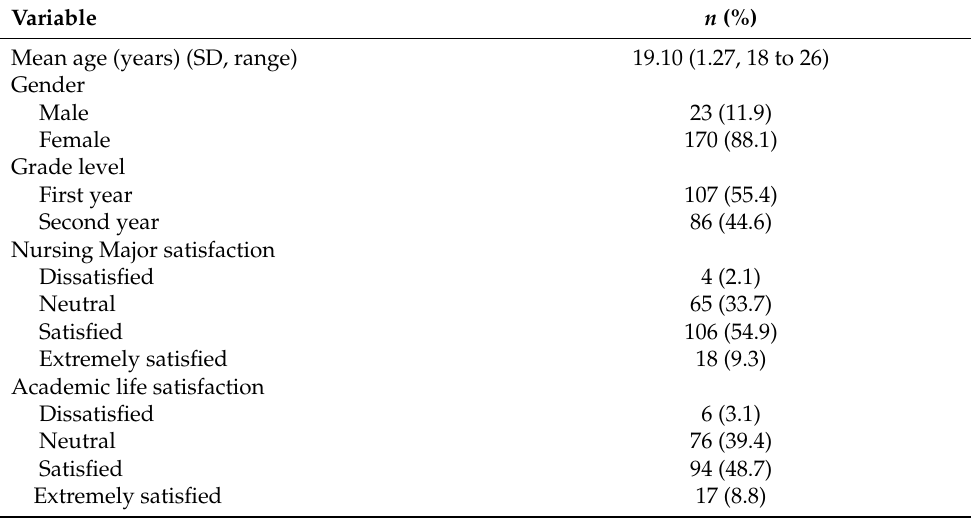
Table 1. Descriptive statistics of the study population ( n = 193).